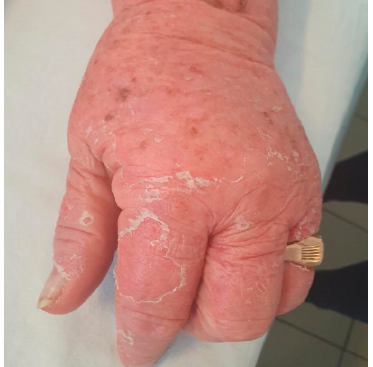
Figure 5. Erythematous skin rash with lamellar desquamation.